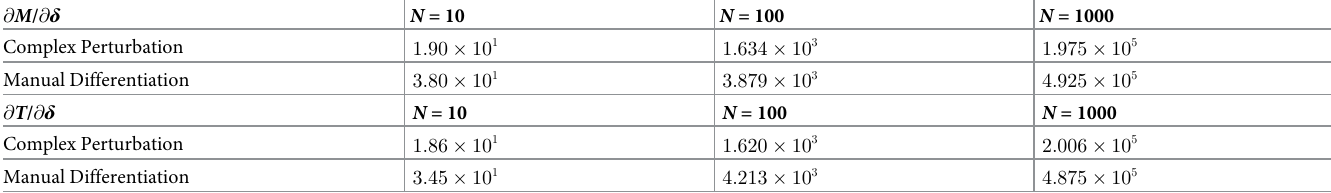
Table 6. Computational time ( μ s) in the stochastic SIR model. Model parameters match those previously described in this manuscript. Manual differentiation relies on differentiating Eq 7 and Eq 6 for the stochastic SIR model.